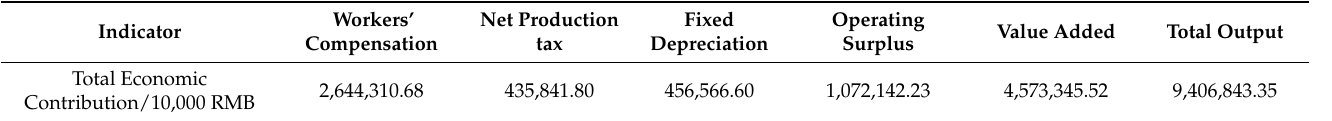
Table 6. Total economic contribution of Xiamen Port to the city in 2017.